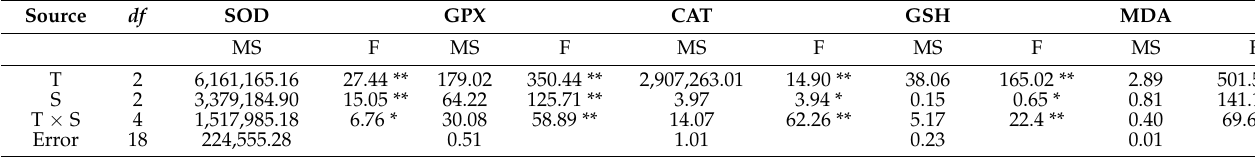
Table 7. MANOVA results using a generalized linear model for the main and interaction effects of temperature and salinity on the antioxidant-related indicators of Perna viridis .